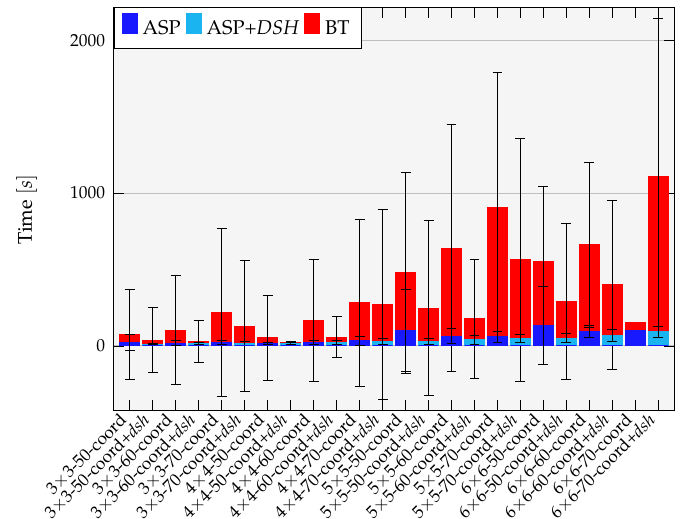
Figure 7. Overview of the average distribution of runtimes of the successful runs using the coordinated approach and the coordinated + DSH approach for all instance sets. The vertical error bars show the standard